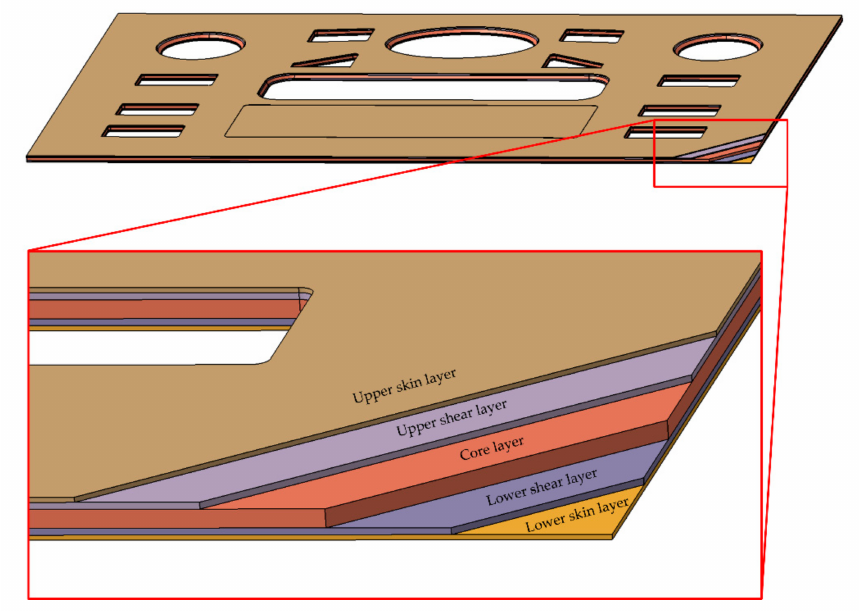
Figure 4. The multi-layer model with five